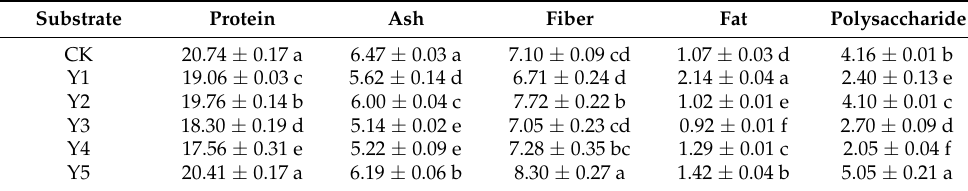
Table 5. Nutritional value of Pleurotus eryngii when cultivated on different substrates # (g 100 g − 1 , mean ± SD, n =